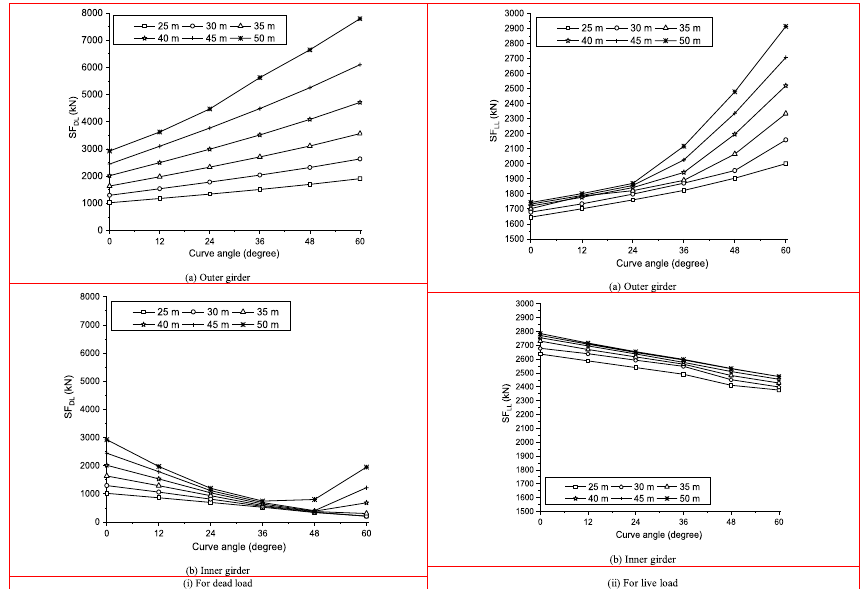
Fig. 10 Variation of shear force with curve angle for different span. a Outer girder. b Inner girder. (i) For